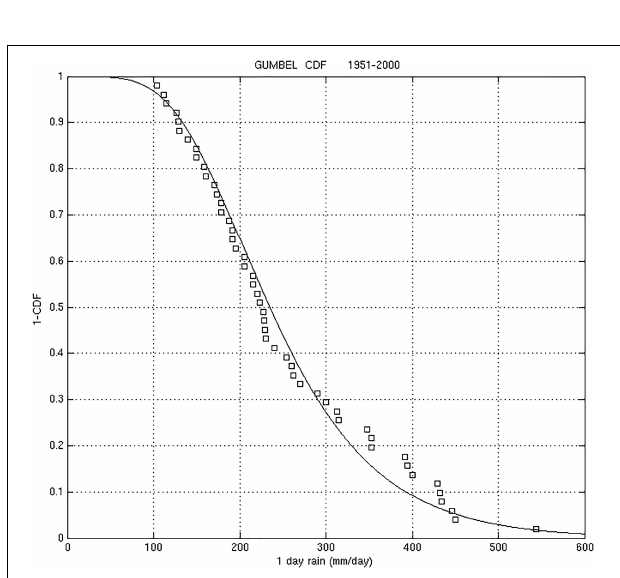
FIGURE 4 | Empirical and Gumbel CDF for the yearly